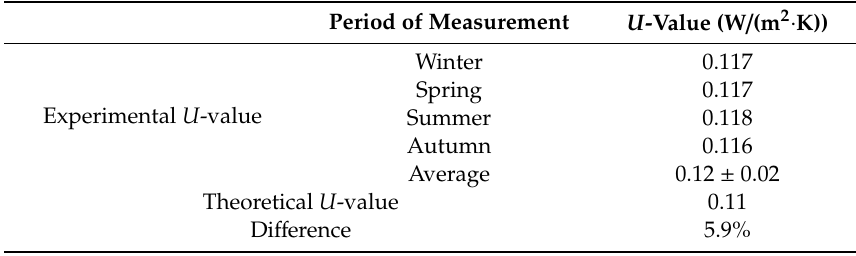
Table 6. Experimental U overall for the north wall of the building